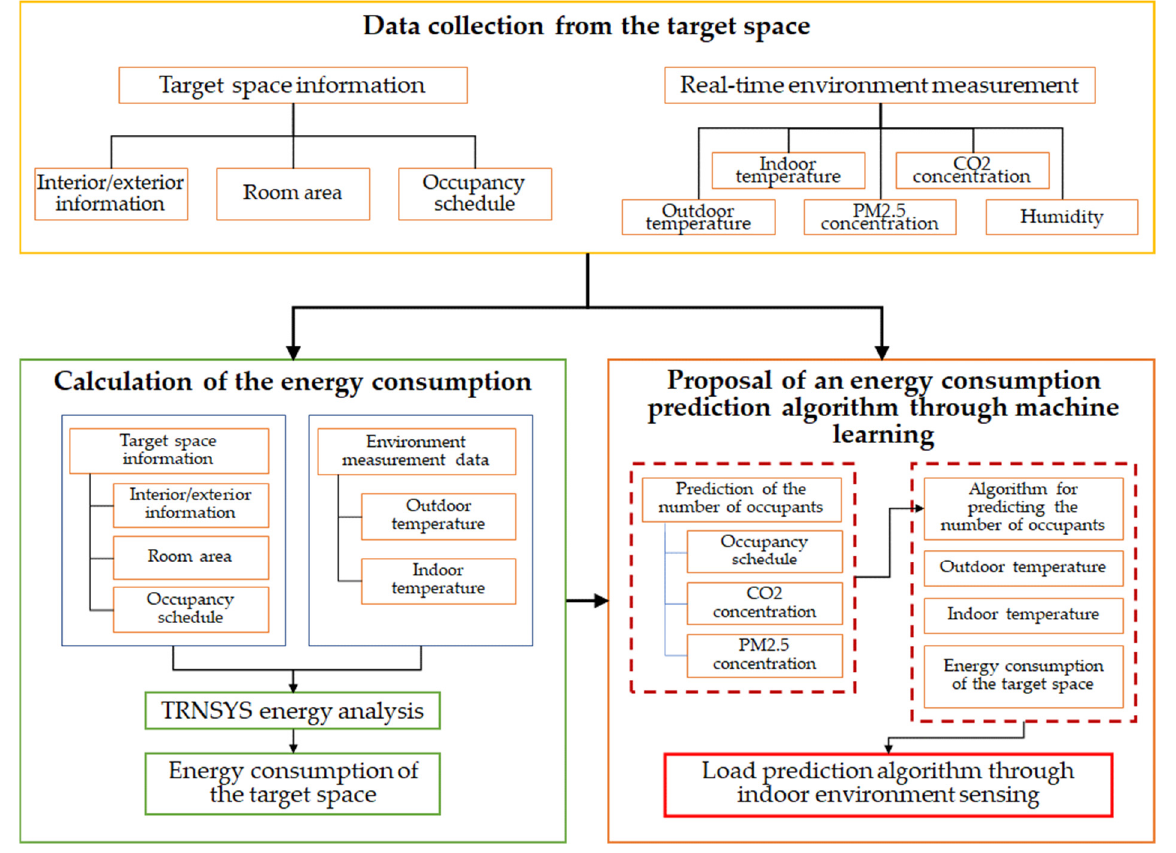
Figure 5. Conceptual diagram of the algorithm for predicting the load according to the number of occupants.